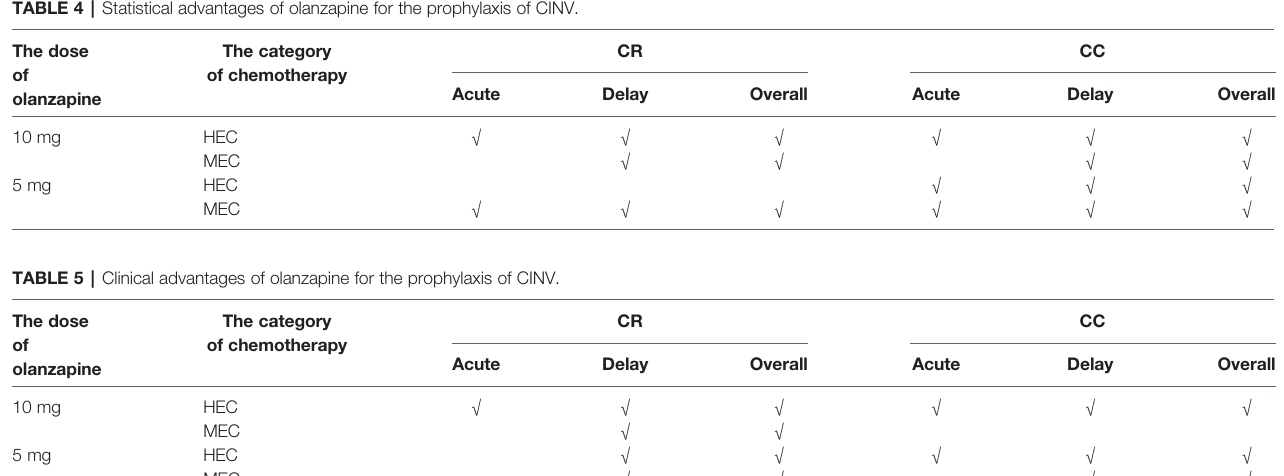
TABLE 4 | Statistical advantages of olanzapine for the prophylaxis of CINV. The dose of